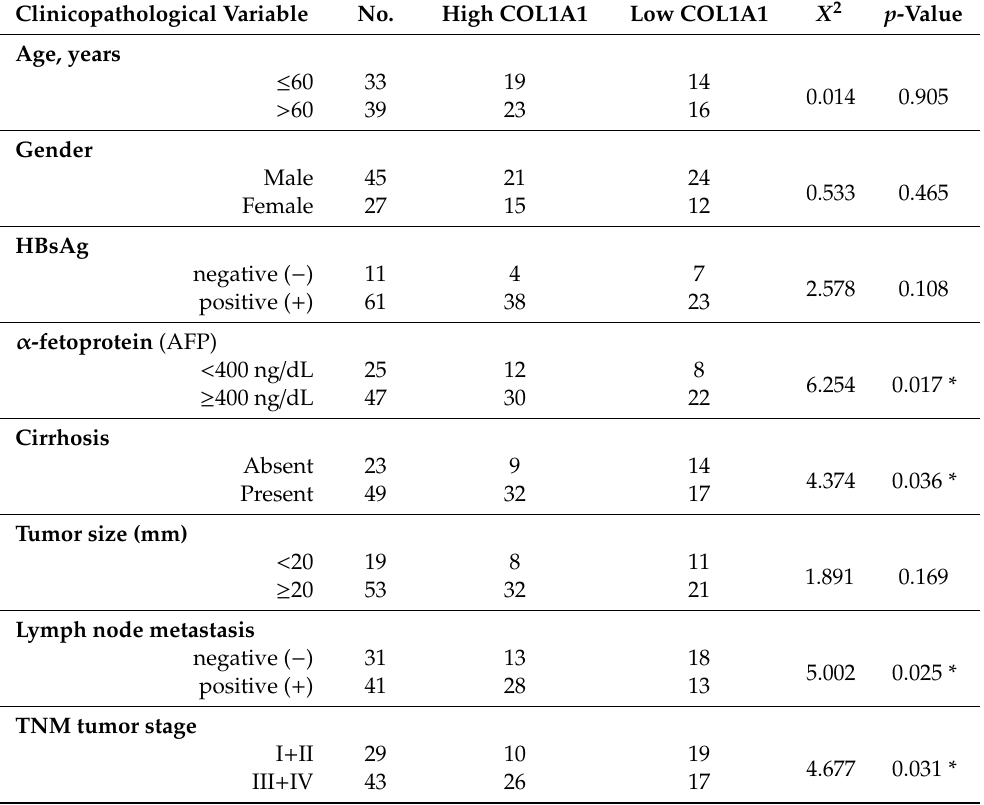
Table 1. Patient clinicopathological characteristics of TMU-SHH HCC cohort. * p < 0.05. Clinicopathological